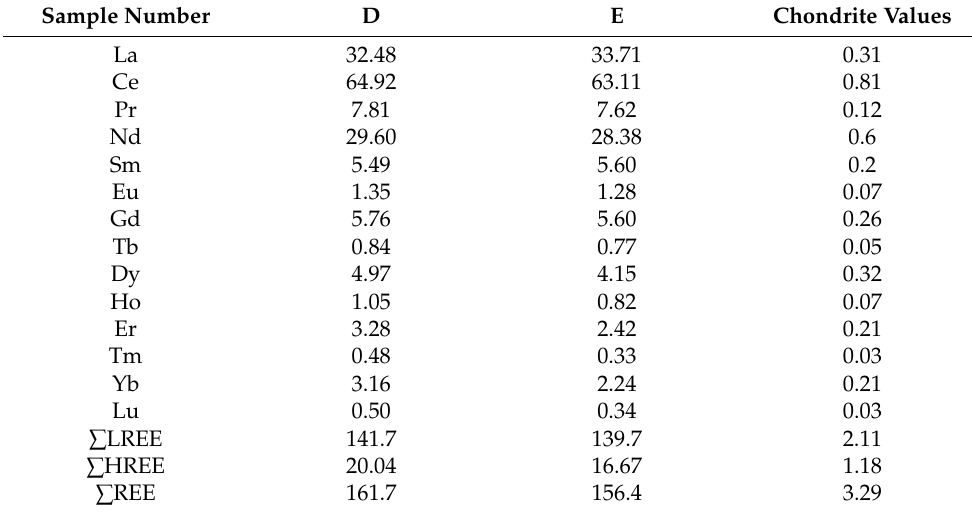
Table 11. Analysis results of rare earth elements in black shale